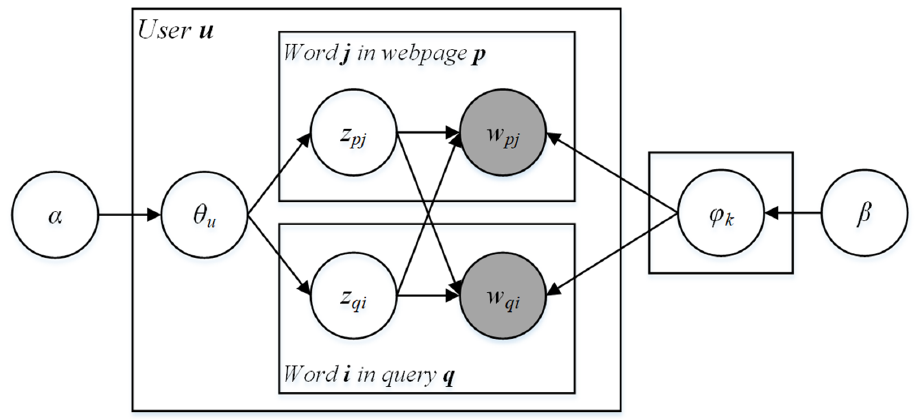
Figure 2. The graphical representation of ALDA model.